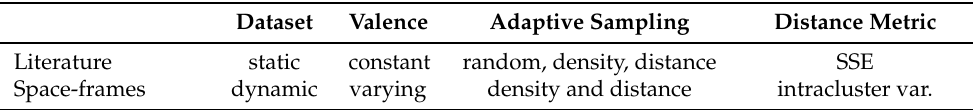
Table 1. Summary of the k -means parameters that change in the context of space-frames, when compared to other applications in the literature. Dataset Valence Adaptive Sampling Distance Metric Literature static constant random, density, distance SSE Space-frames dynamic varying density and distance intracluster